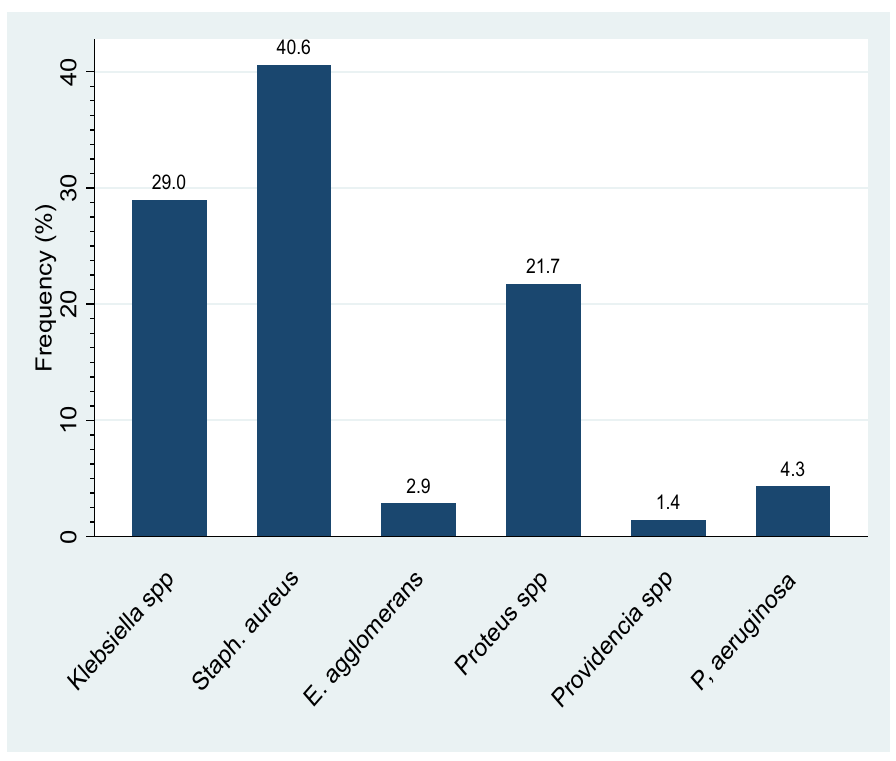
Figure 2. Specific prevalence of chronic wound infection isolates. This figure shows the specific prevalence of isolates in chronic wound infection. Seventy five (75) wound swabs were inoculated on routine laboratory culture media for growth and pathogens were identified based on morphological, cultural characteristics and biochemical tests. Six (6) types of isolates were identified in the following order of prevalence; Staphylococcus aureus (40.6%), Klebsiella species (29.0%), Proteus species (21.7%), Pseudomonas aeruginosa (4.3%), Enterobacter agglomerans (2.9%) and Providentia species